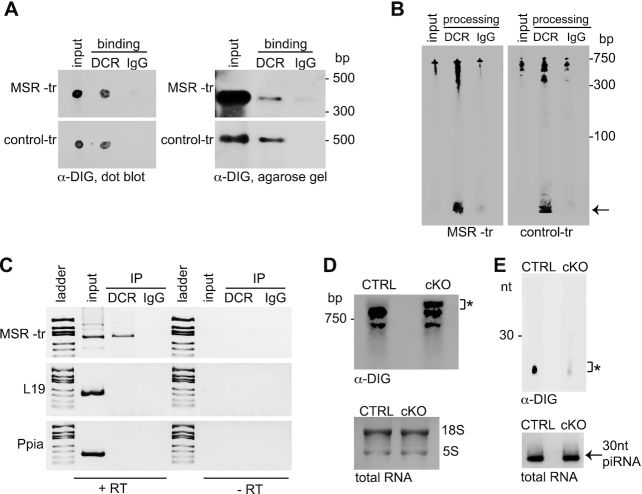
DICER binds and processes major satellite repeat transcripts. (A) DICER interacts with MSR transcripts (MSR-tr) in vitro. DIG-labelled in vitro transcribed MSR or randomly-selected control transcripts were incubated with DICER-complexes (DCR) immunoprecipitated from mouse testes. Rabbit IgG (IgG) was used as a negative control for immunoprecipitation. Binding was detected by anti-DIG antibody both by dot blotting (left panel) or by running bound RNA into an agarose gel followed by transfer to a membrane (right panel). Both MSR-tr and control-tr bound to DICER complexes, while no binding was detected in the negative IgG control. (B) DICER complexes are able to process MSR transcripts in vitro. DIG-labeled MSR or control transcripts were incubated with testis DICER-complexes and RNA was run into a polyacrylamide gel for anti-DIG detection. Both MSR and control transcripts were processed into smaller products by DICER complexes (black arrow) but not by control IgG immunoprecipitations. (C) MSR transcripts form complexes with DICER in the testis in vivo. Cross-linked testicular extracts were immunoprecipitated by anti-DICER or control rabbit IgG antibodies, and co-precipitated RNAs were detected by RT-PCR using primers specific for MSR transcripts. L19 and Ppia (peptidylprolyl isomerase A) primers were used as negative controls. In the -RT reaction, cDNA synthesis reaction was performed in the absence of reverse transcriptase. (D) Long MSR transcripts accumulate in Dicer1 cKO testes. Total RNA was extracted from control (CTRL) and Dicer1 cKO (cKO) testes and run into an agarose gel for Northern blotting using DIG-labeled MSR forward transcript probes. The longer MSR transcripts that appear only in cKO testes are indicated by an asterisk. Total RNA was stained to visualize 18S and 5S rRNAs for the validation of equal loading of RNA. (E) MSR transcript-derived small RNAs are dramatically reduced in Dicer1 cKO testes. Small RNAs from control and Dicer1 cKO testes were run into a polyacrylamide gel and MSR forward transcript-derived small RNAs (asterisk) were detected by Northern blotting. Small RNAs were stained to visualize ∼30 nt piRNAs (black arrow) for the validation of equal loading of RNA. All panels show a representative figure of an experiment that was independently repeated at least two times.